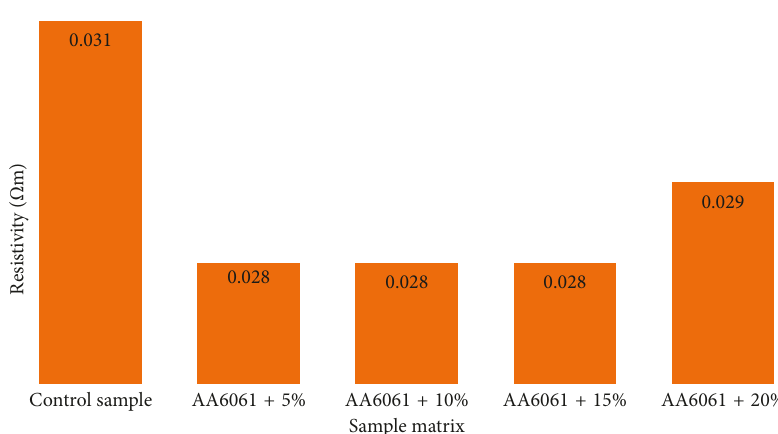
Figure 16: Effect of snail shells on the resistivity of the reinforced aluminium